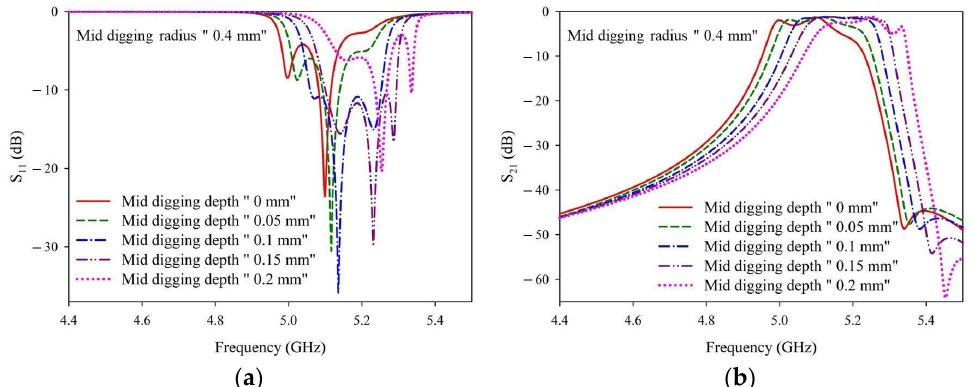
Figure 6. ( a ) S 11 and ( b ) S 21 simulation results with a fixed digging radius of 0.4 mm and various digging depths.